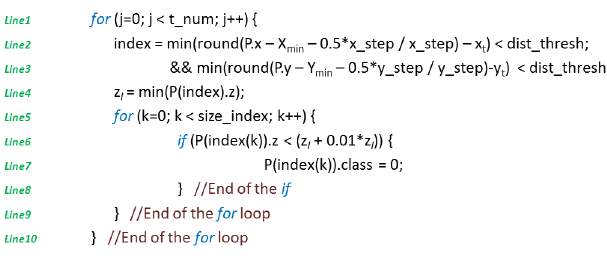
Figure 4: Pseudocode of the algorithm for filtering the ground points of the tree